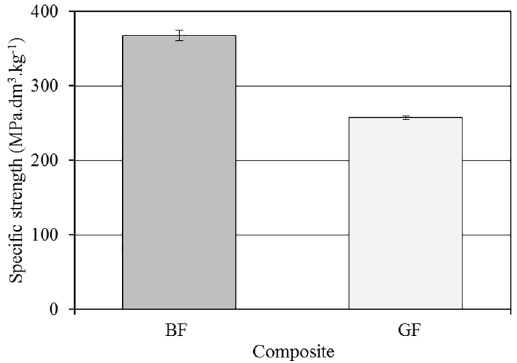
Figure 9. Comparison of ring tensile specific strength between BF and GF composites (mean